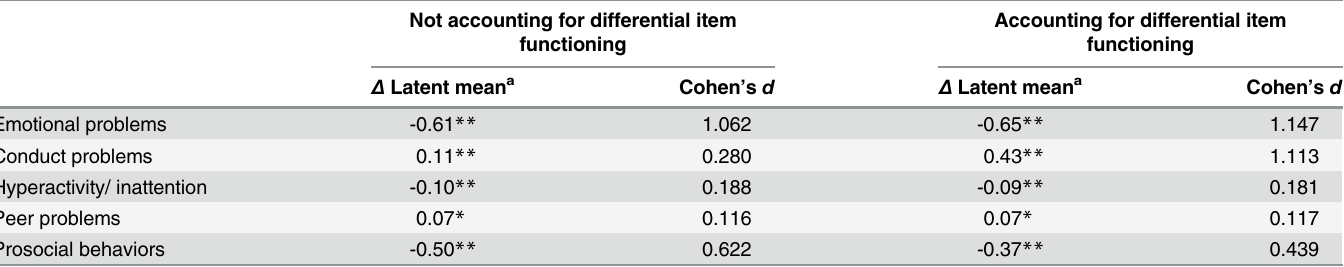
Table 3. Differences in latent factor mean between girls and boys when differential item functioning for gender is not accounted for, and when it is accounted for.